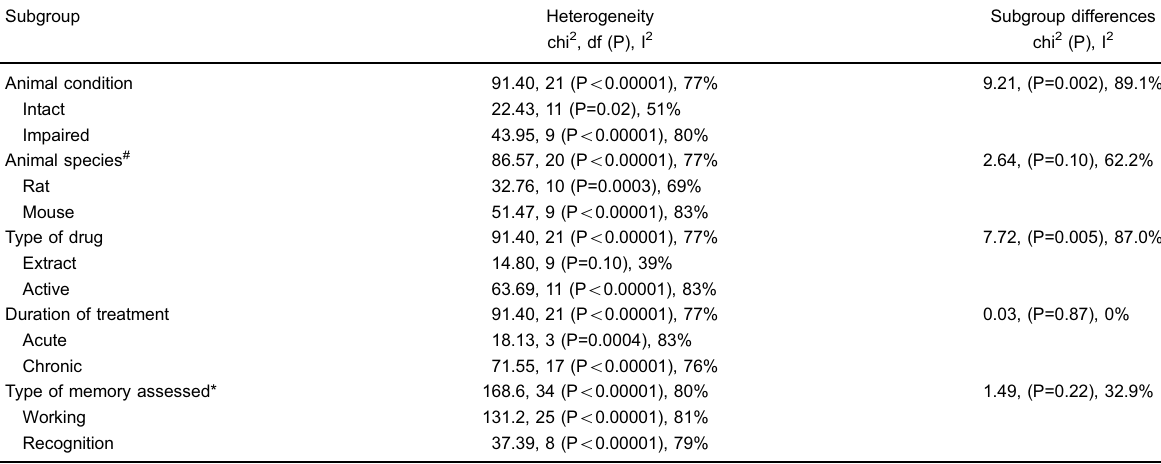
Table 2. Subgroup analyses for heterogeneity and group differences (chi 2 and I 2 tests).